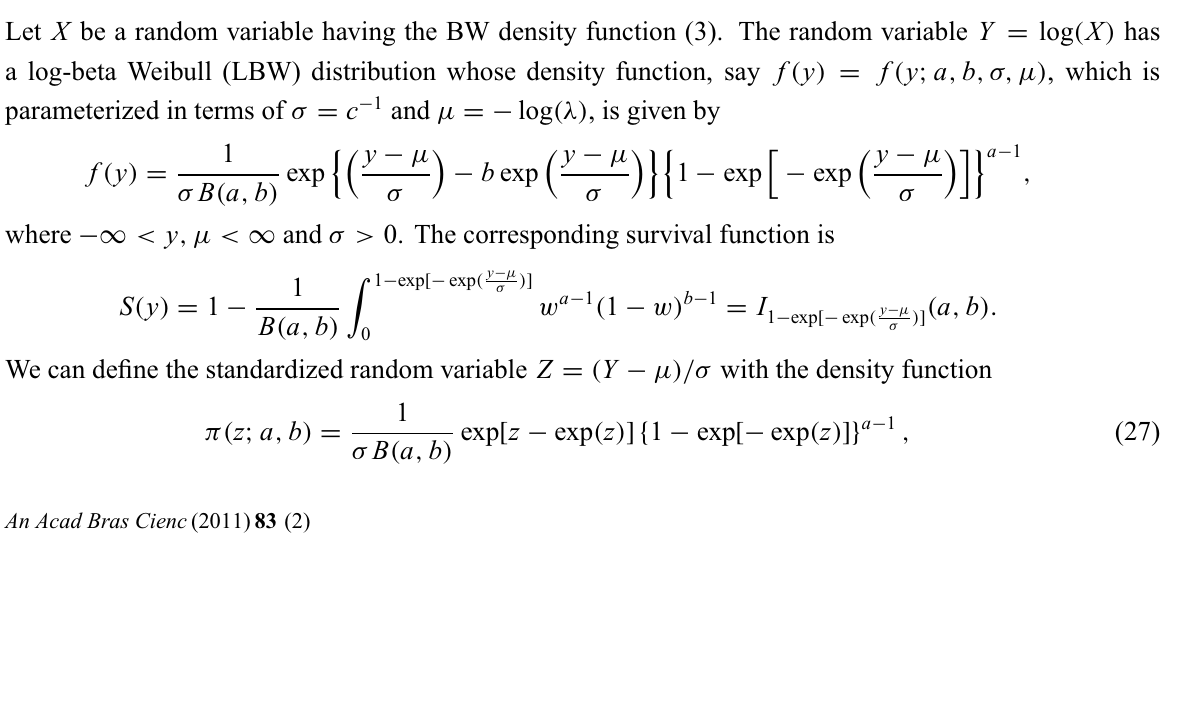
Fig. 7 – The probability density function (3) of the fitted BW and Weibull distributions. THE LOG-BETA WEIBULL